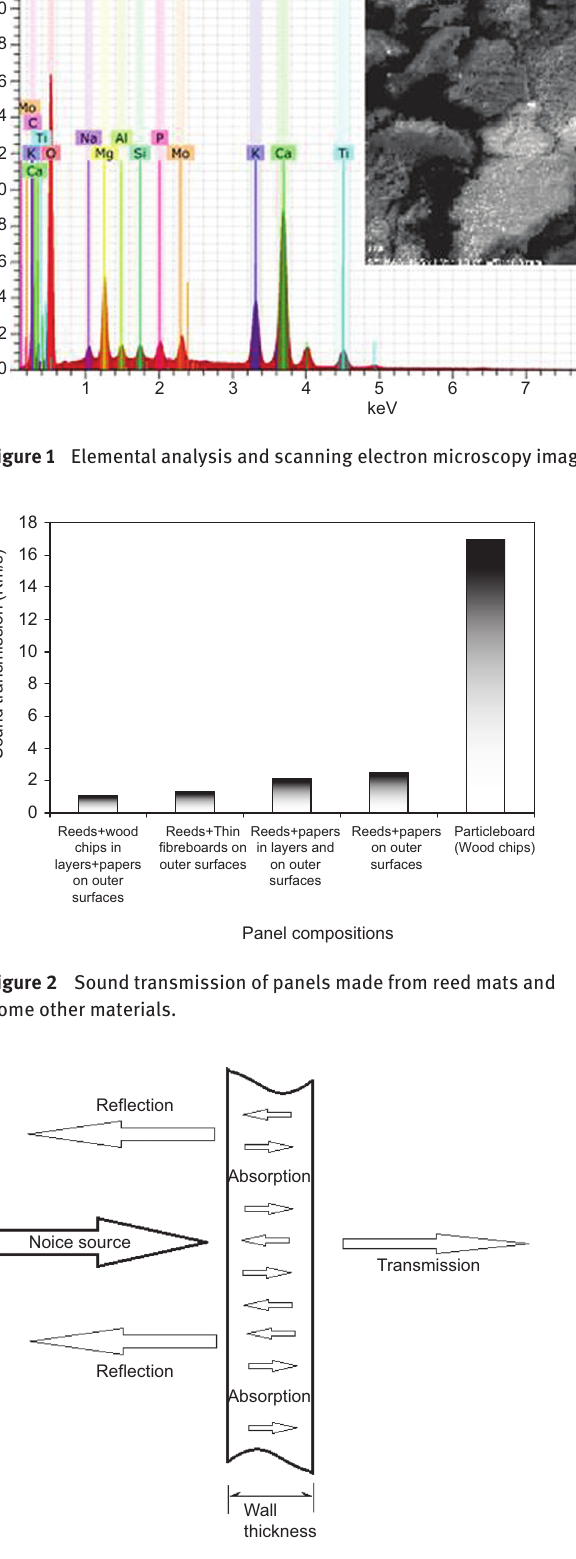
Picture 5 Behavior of a sound (noise) when facing an obstacle. Figure 3 Sound transmission of particleboards containing reed